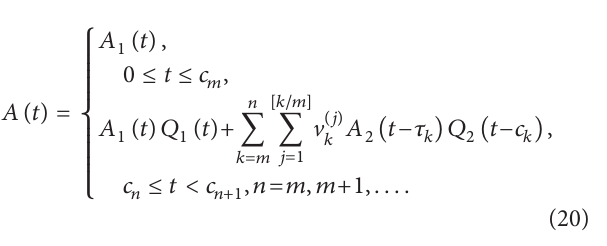
a renewal process under model A and they are independent and identically distributed; thus, 𝐴 2 (𝑡) = 𝐴 1 (𝑡) and 𝑄 2 (𝑡) = (𝑡) under model A. Hence, we have the following 𝑄 1